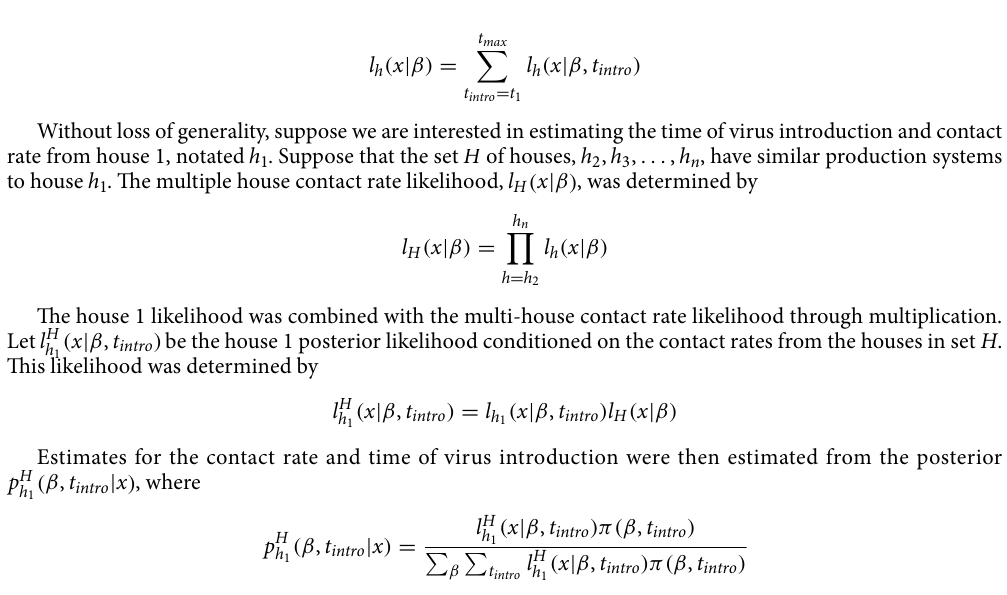
Figure 1. A contour plot of the posterior likelihood and plots of the marginal posterior likelihoods for the adequate contact rate and day of virus introduction estimated from the Kandiyohi 1 house 1